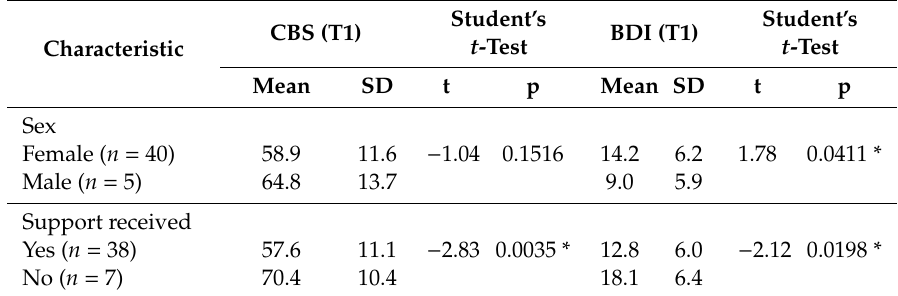
Table 8. Comparison of the CBS and BDI results according to gender and assistance received (Student’s t -test for independent